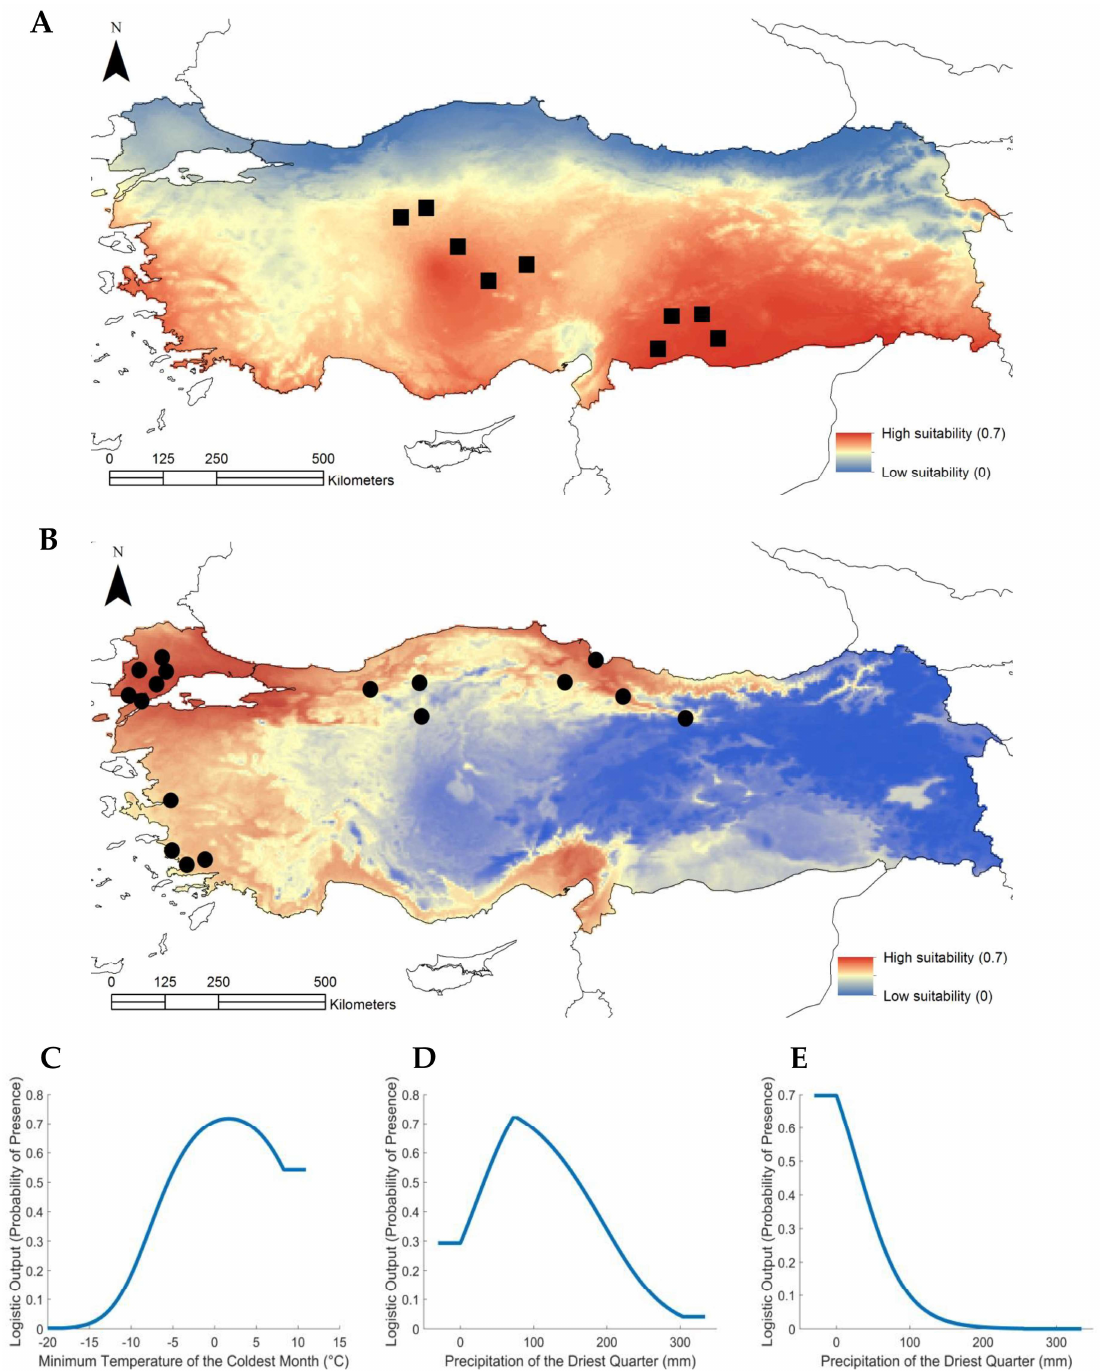
Figure 4. Bioclim modelling of environmental variables. These indicated the climate suitability of Brachypodium subpopulations in Turkey. ( A ) Color-coded, Maxent model climate suitability for the central subpopulation. Black squares represent sampling sites for the central subpopulation; ( B ) Maxent model climate suitability for the coastal subpopulation. Black circles represent sampling sites for the coastal subpopulation; ( C ) Maxent model response curve for the relationship between the probability of presence of the coastal subpopulation and the Minimum Temperature of the Coldest Month (°C); ( D ) Maxent model response curve for the relationship between the probability of presence of the coastal subpopulation and the Precipitation of the Driest Quarter (mm); ( E ) Maxent model response curve for the relationship between the probability of presence of the central subpopulation and the Precipitation of the Driest Quarter (mm).